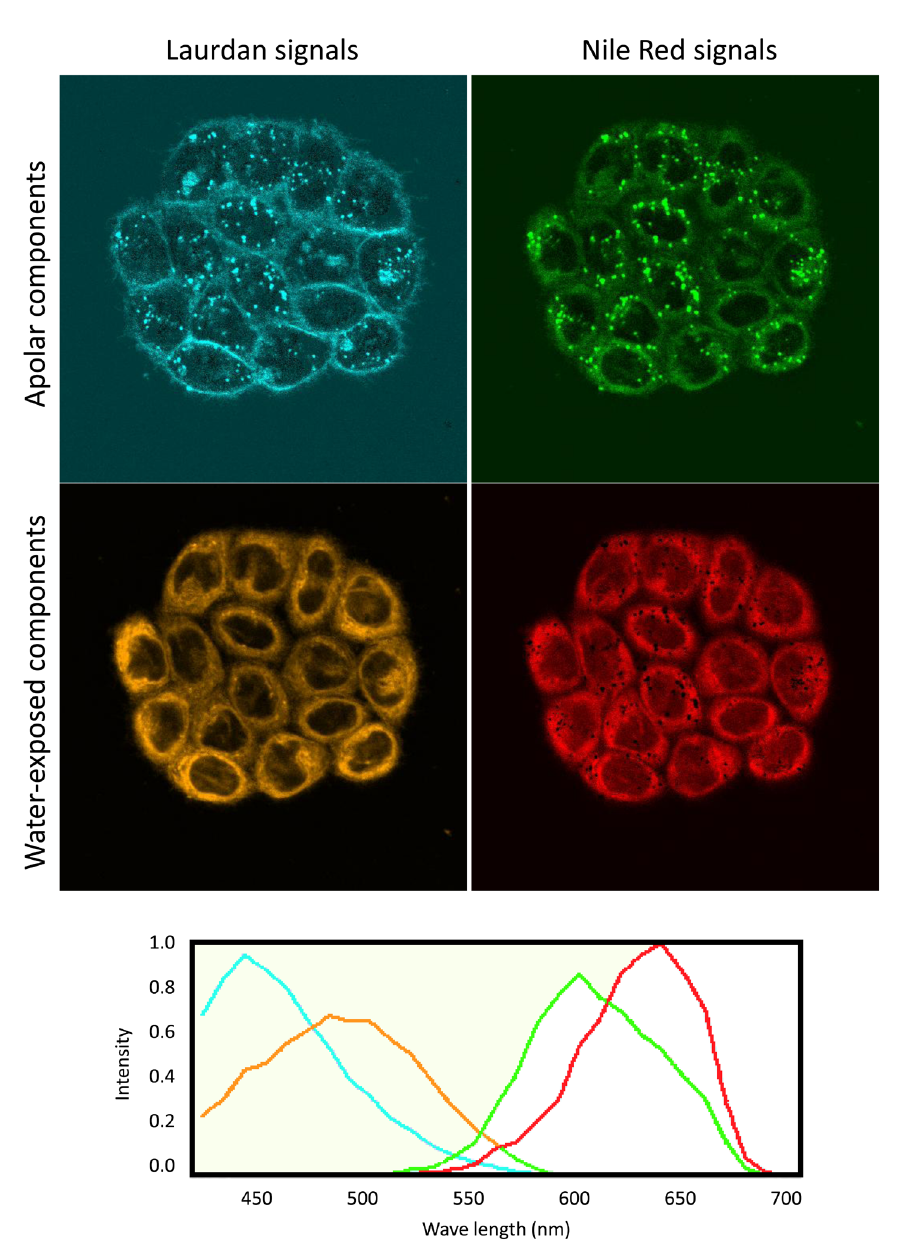
Figure 6. Using the spectra acquired on MLVs and the poisson NMF pluggin in ImageJ, the acquired image stacks can be efficiently separated in as many as 4 different colours. The poisson-NMF pluggin was used to perform spectral deconvolution on the lambda-stack obtained with live cells labelled with both Laurdan and Nile red (see Figure 3). Reference curves used (lower panel) were those obtained on MLVs labelled either with Laurdan (DPPC-cholesterol (Lo): cyan curve, DOPC(Ld): orange curve) or with Nile red (DPPC-cholesterol (Lo): green curve, DOPC(Ld): red curve). Settings used were all as described in M&M. The four panels correspond to: Upper-left (cyan): Laurdan in apolar (hydrophobic) environment; Lower-left (orange): Laurdan in water-exposed environment; Upper-right (green): Nile red in apolar (hydrophobic) environment; Lower-right (red): Nile red in water-exposed environment. Laurdan Nile Red 02 from 07 April